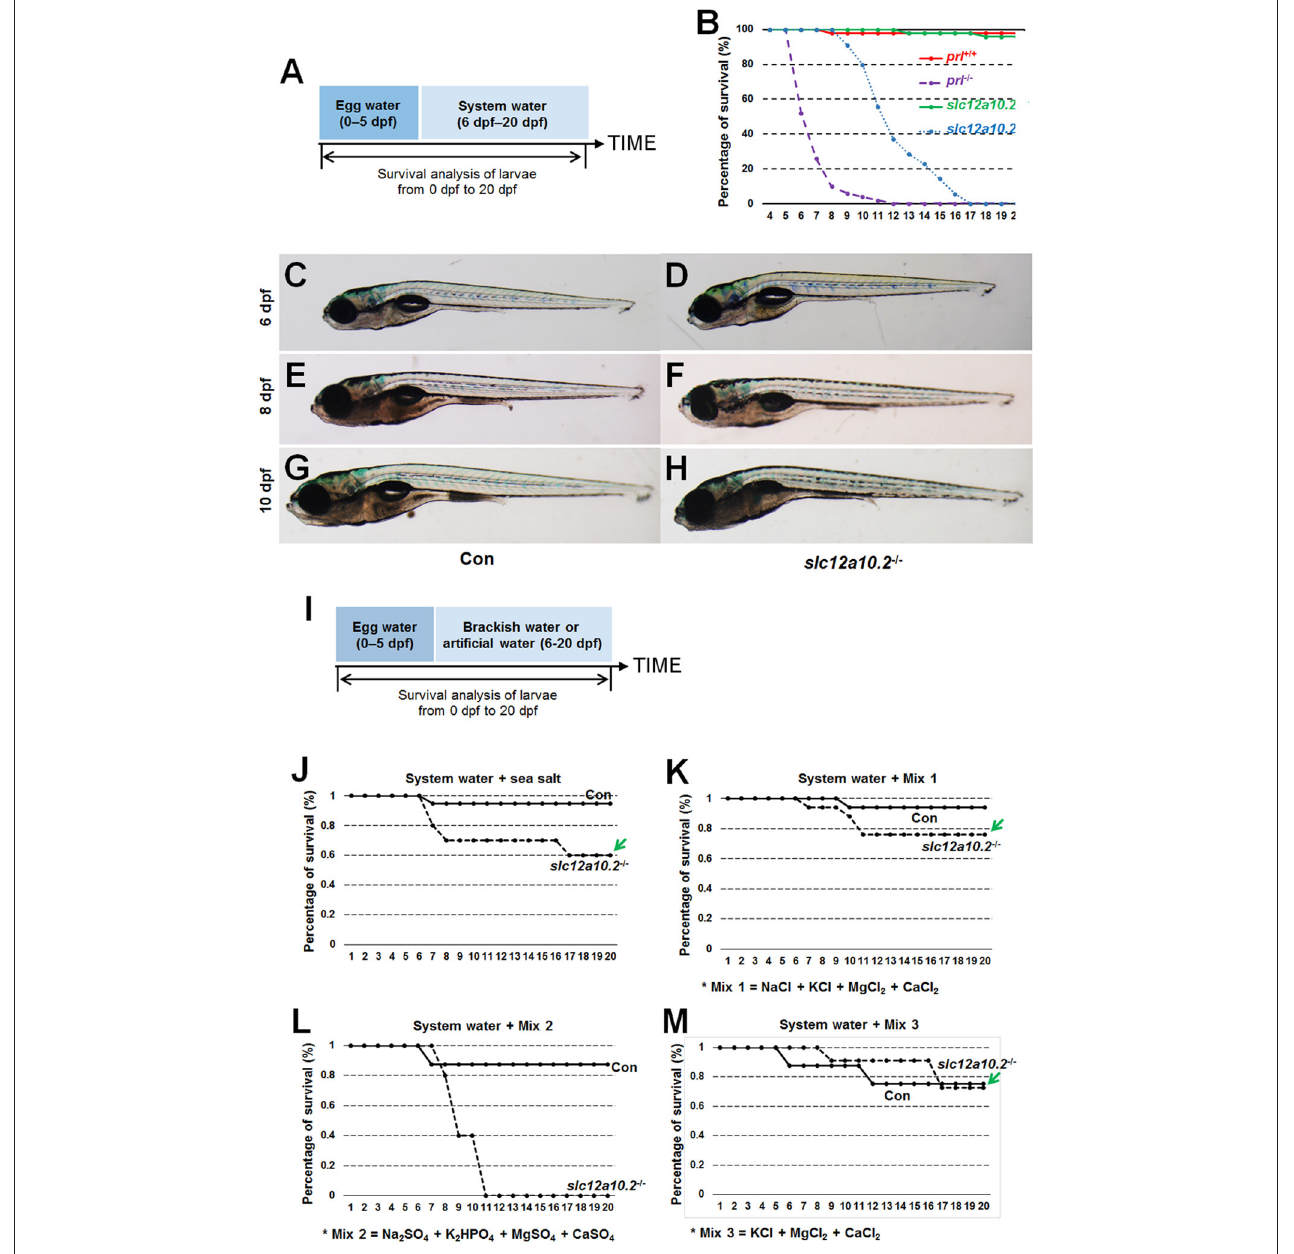
FIGURE 2 | The lethality of the slc12a10.2 -deficient zebrafish is rescued by exogenous Cl − supplement. (A) Schematic diagram of the rearing timeline. Larvae were reared in egg water from 0 to 5 dpf, and in system water after 5 dpf. The survival ratio of fish reared under this condition was analyzed until 20 dpf. (B) Comparison of the survival ratios of prl + / + , prl − / − , slc12a10.2 + / + , and slc12a10.2 − / − larvae ( n = 25 for each genotype). (C–H) The general morphological observations of control larvae and slc12a10.2 -deficient larvae at 6, 8, and 10 dpf. (C,E,G) Control larvae. (D,F,H) slc12a10.2 -deficient larvae. (I) Schematic diagram of the rearing timeline. Larvae were reared in egg water from 0 to 5 dpf and in brackish or artificial water after 5 dpf. The survival ratios of fish reared under different conditions were analyzed until 20 dpf. (J–M) The survival ratios of control and slc12a10.2 -deficient larvae in system water + sea salt, system water + Mix 1, system water + Mix 2, and system water + Mix 3.